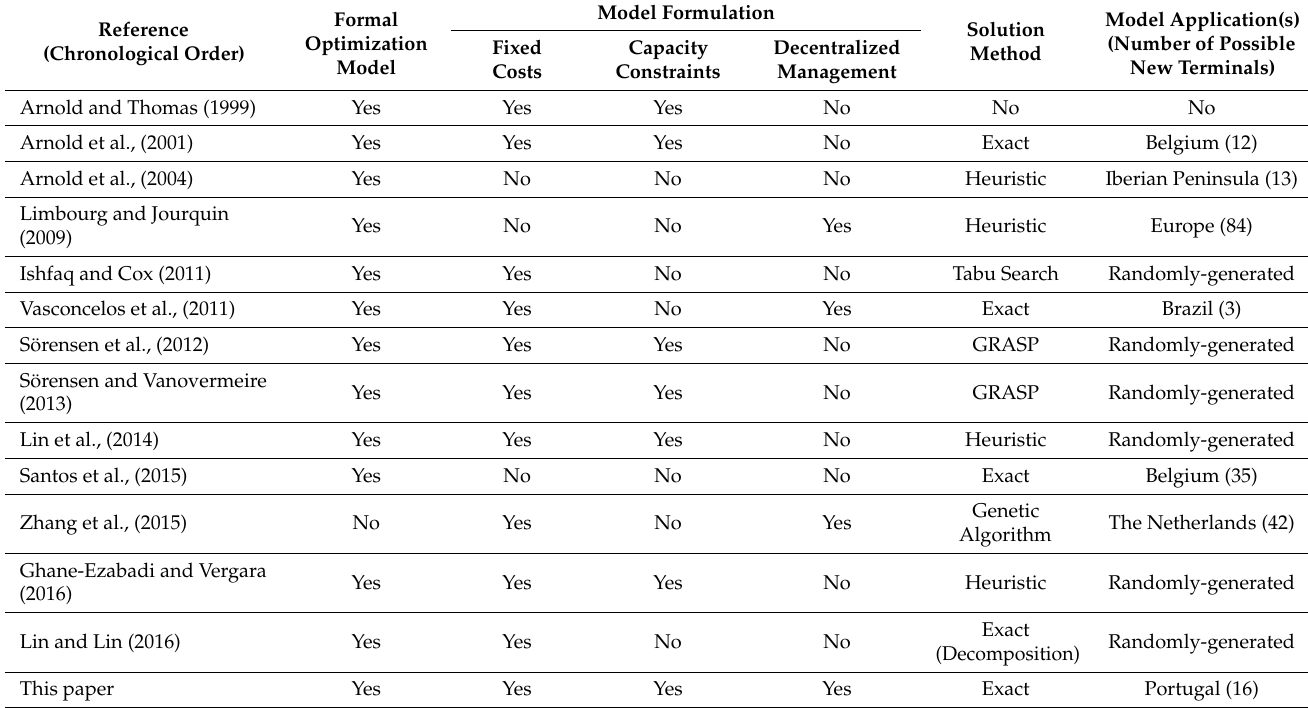
Table 3. Related work on intermodal terminal location problems (compared to that presented in this